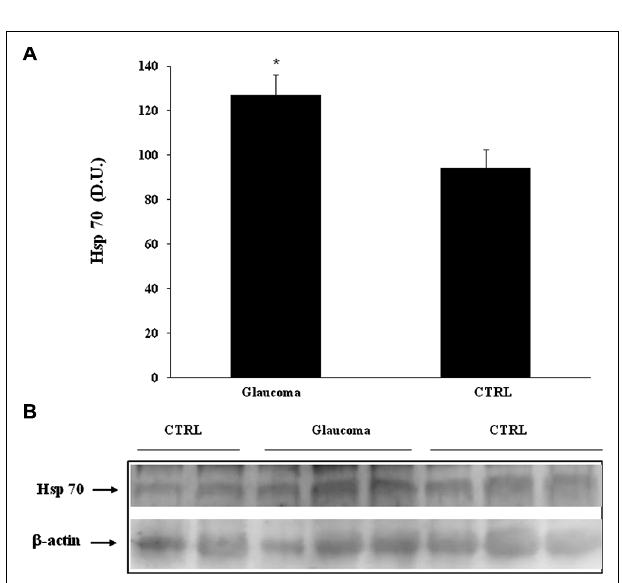
FIGURE 1 | (A) HSP-70 protein levels in plasma of glaucoma and control subjects. Samples from control and glaucoma patients were assayed for HSP-70 expression byWestern blot. A representativ eimmunoblot is shown. β -actin has been used as loading control. (B) Densitometric evaluation: the bar graph shows the values are expressed as mean standard error of mean of 3 independent analyses. * P < 0.05 vs. control. D.U., densitometric units; CTRL,